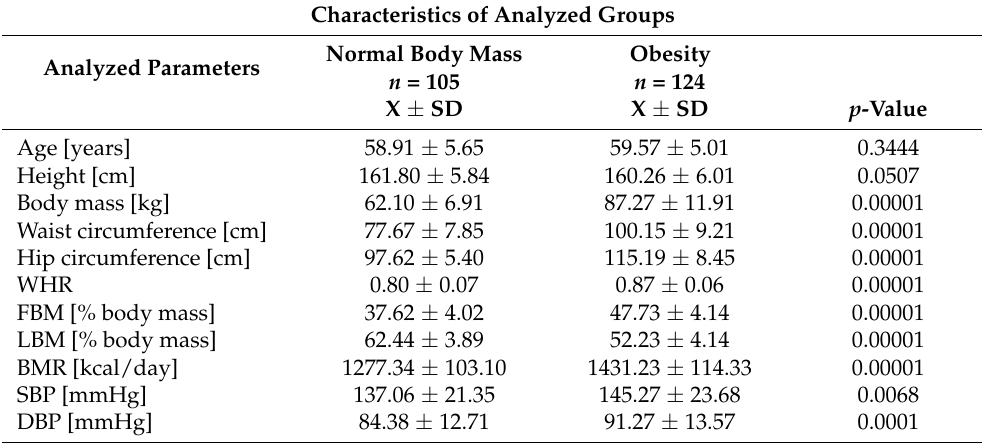
Table 1. Characteristics of analyzed groups of lean and obese postmenopausal women.